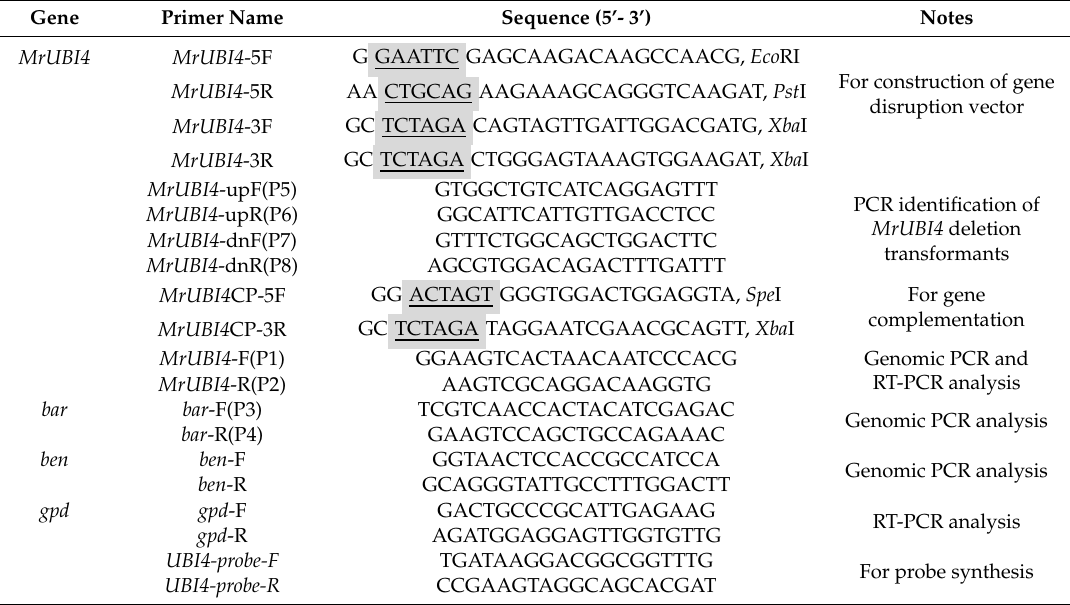
Table 1. Primers used for gene deletion and